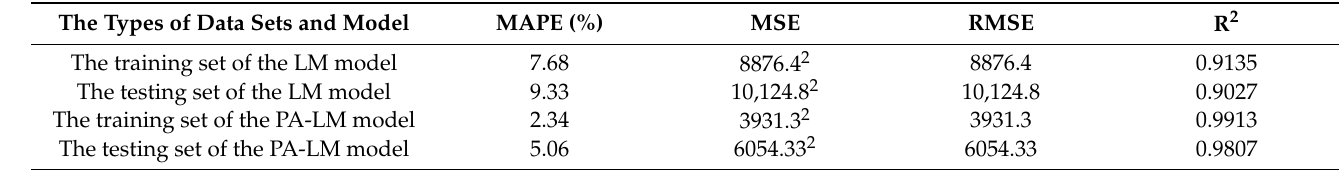
Figure 9. Comparisons of the COP values predicted by the LM and PA-LM models: ( a ) typical data 1; ( b ) typical data 2; ( c ) typical data 3; ( d ) typical data 4. Table 4. Comparisons of MAPE, MSE, RMSE, and R 2 of the initial data sets for the LM and PA-LM models.